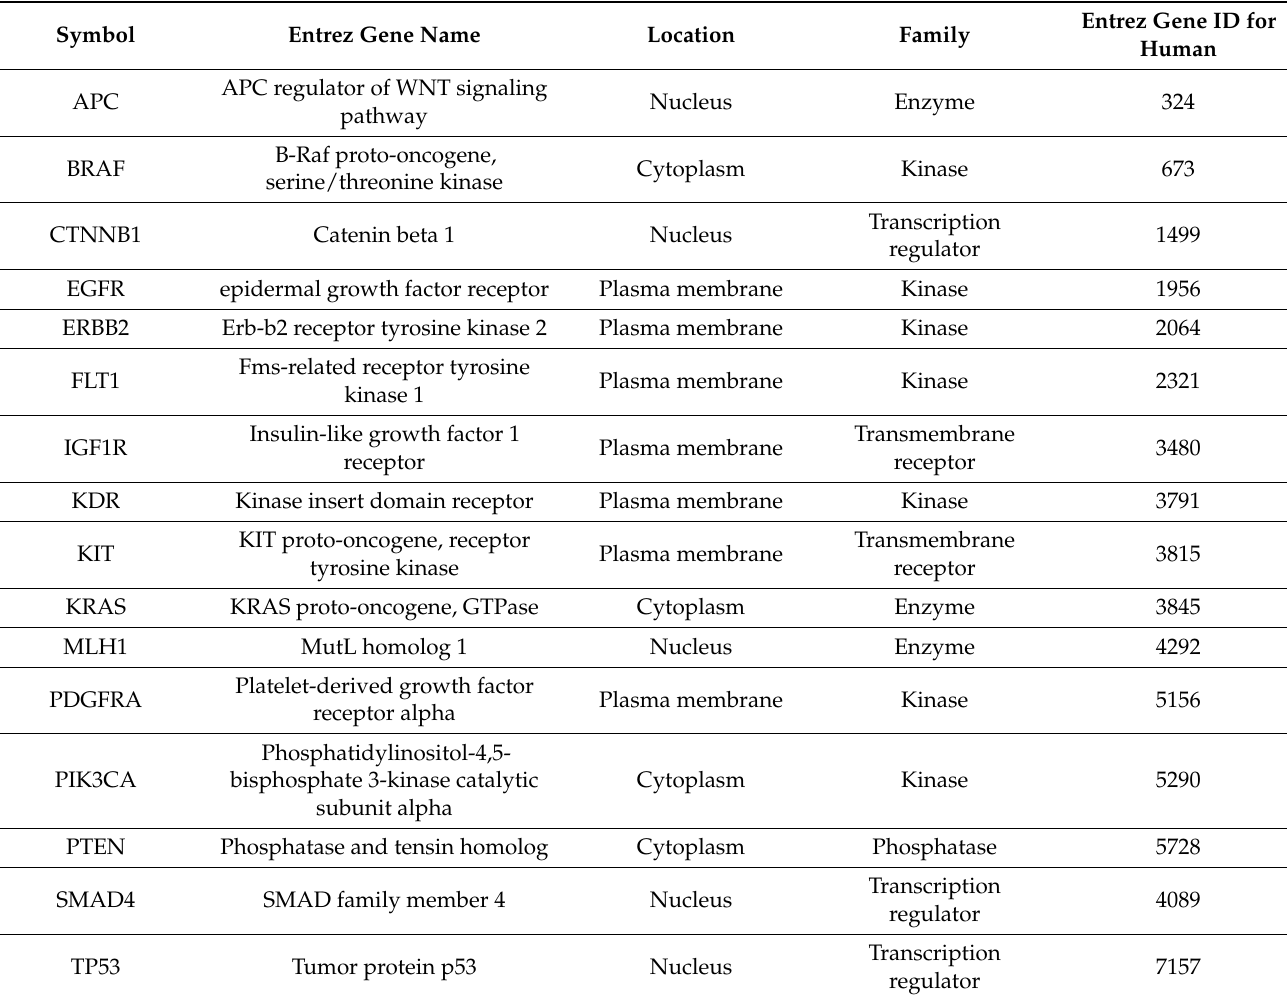
Table 4. Candidate biomarkers from the list of 75 genes with pathogenic mutations in the large intestine.